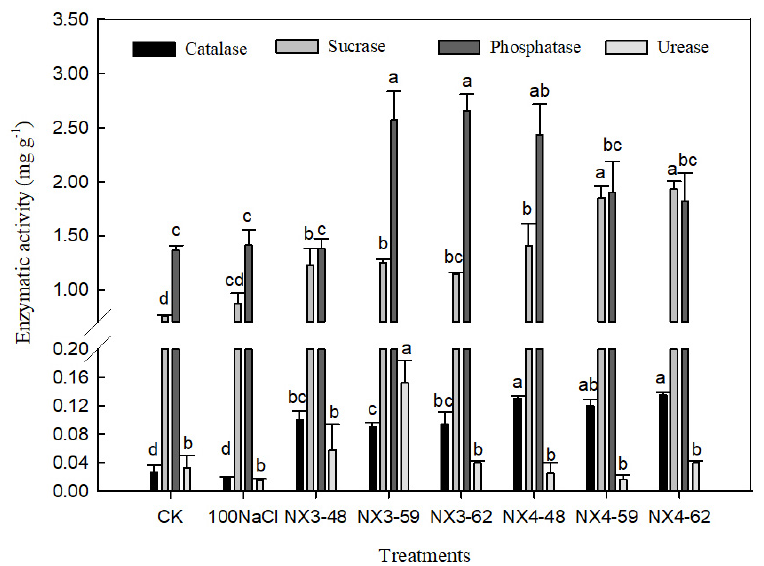
Figure 5. Soil enzymatic activity in a pot experiment in which cucumber seedlings inoculated with a combination of Bacillus licheniformis and Bacillus subtilis under salt stress were grown for 40 days. Bars represent standard errors. Different letters indicate a significant difference in the same parameter at p < 0.05.